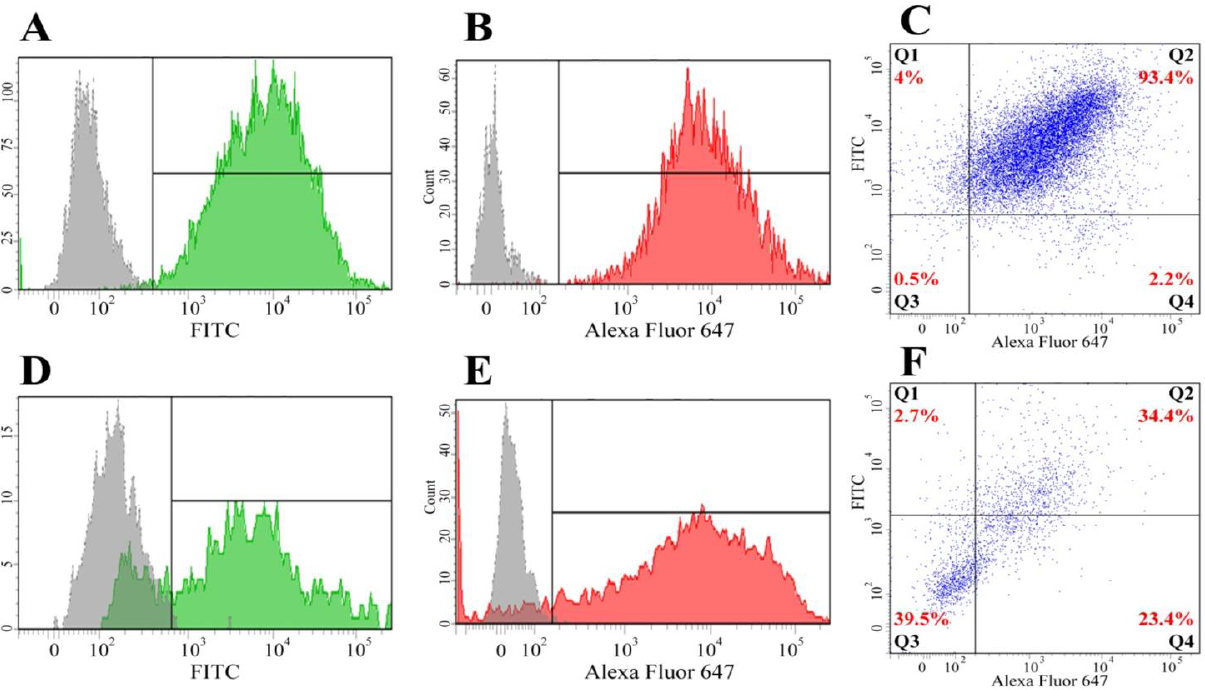
Figure 5. Flow cytometry analysis of BM-MSCs and SH-SY5Y cells after co-culture for 96 h. ( A–C ) Plastic. ( D–F ) Matrigel. ( A , D ) SH-SY5Y cells (monoculture) colored with vital DiO dye. ( B , E ) BM-MSCs (monoculture) colored with the vital DiD dye. ( C , F ) BM-MSCs and SH-SY5Y cells after co-cultivation (co-culture). Q1—population of cells with green fluorescence (DiO). Q2—population of cells with mixed fluorescence (DiO + DiD). Q3—unstained population. Q4—population of cells with red fluorescence (DiD).